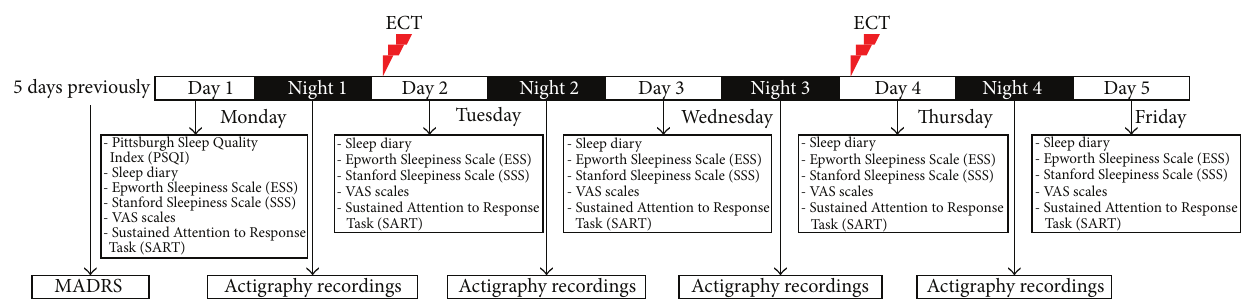
Figure 1: Schematic representation of the study protocol and